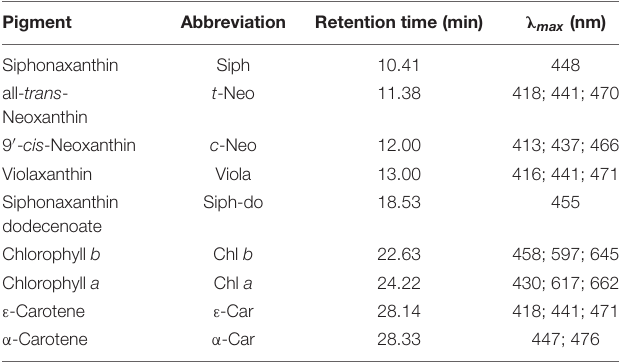
TABLE 1 | Pigment composition of Codium tomentosum and Bryopsis plumosa analyzed with HPLC.